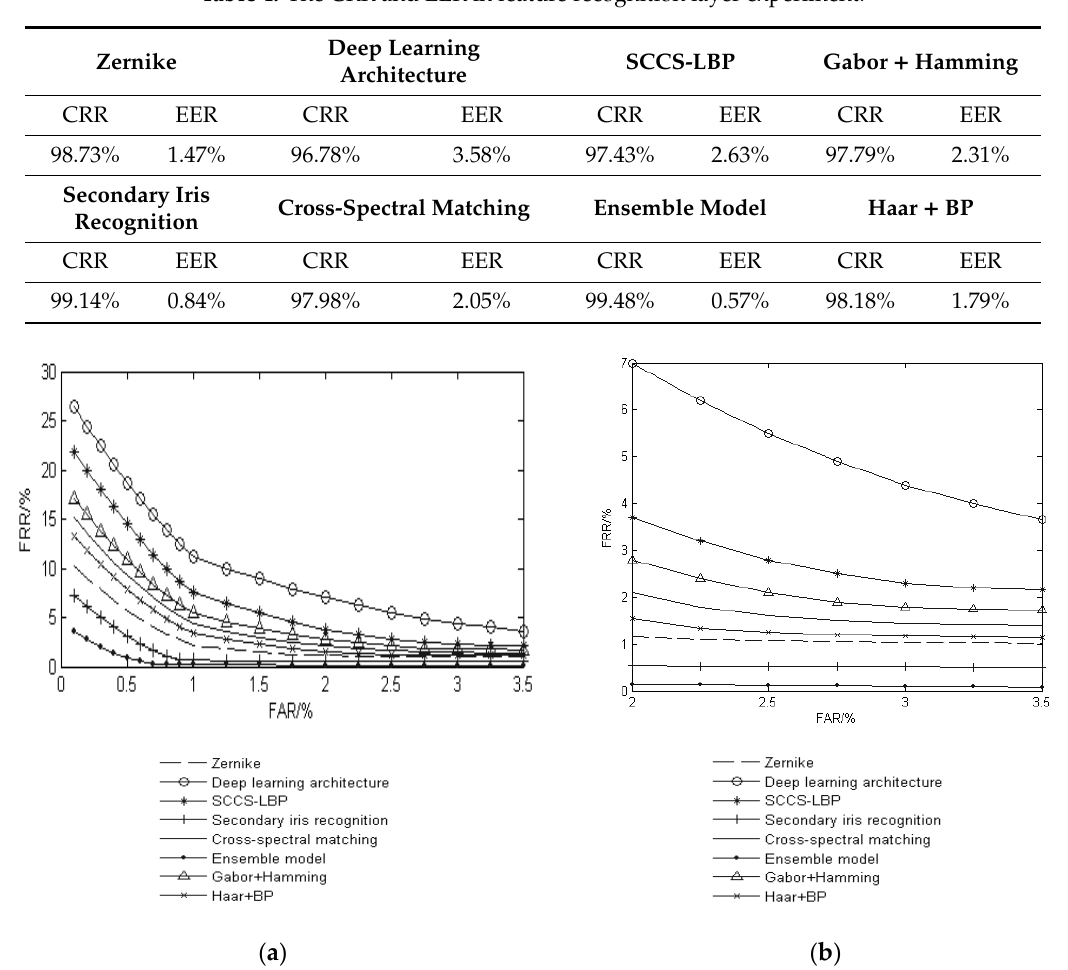
Table 4. The CRR and EER in feature recognition layer experiment.